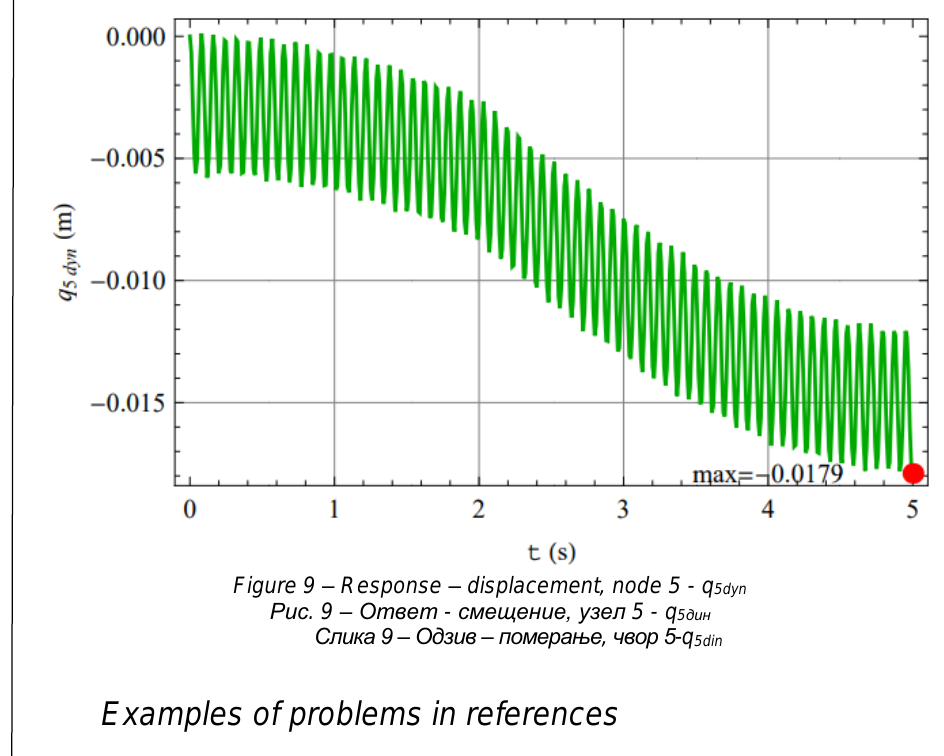
Figure 9 – Response – displacement, node 5 - q 5dyn Рис. 9 – Ответ - смещение, узел 5 - q 5дин Слика 9 – Одзив – померање, чвор 5-q